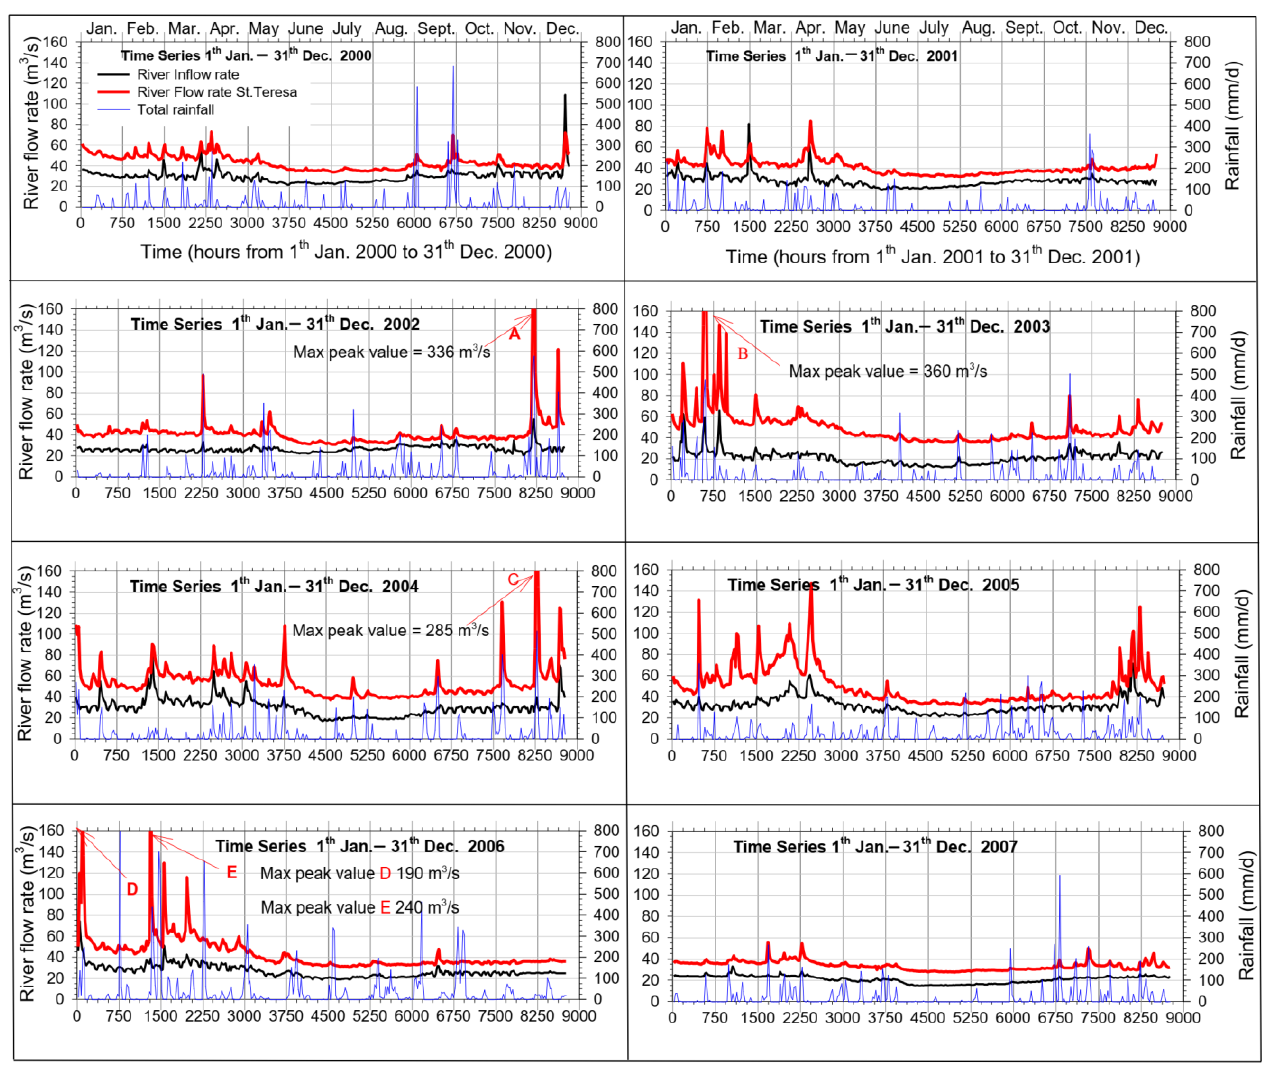
Figure 2. Time series comparison of the river flow rate (Pescara, S. Teresa), river inflow rate (Pescara-Maraone increased by Tirino-Madonnina) and rainfall from year 2000 to 2007. Red line: river flow rate at Pescara S.Teresa; black line: river inflow rate; blue dashed line: rainfall. Red arrows indicate the maximum value of the exceptional river flow rate peaks: A = 336 m 3 /s, B = 360 m 3 /s, C = 285 m 3 /s, D = 190 m 3 /s, E = 240 m 3 /s.